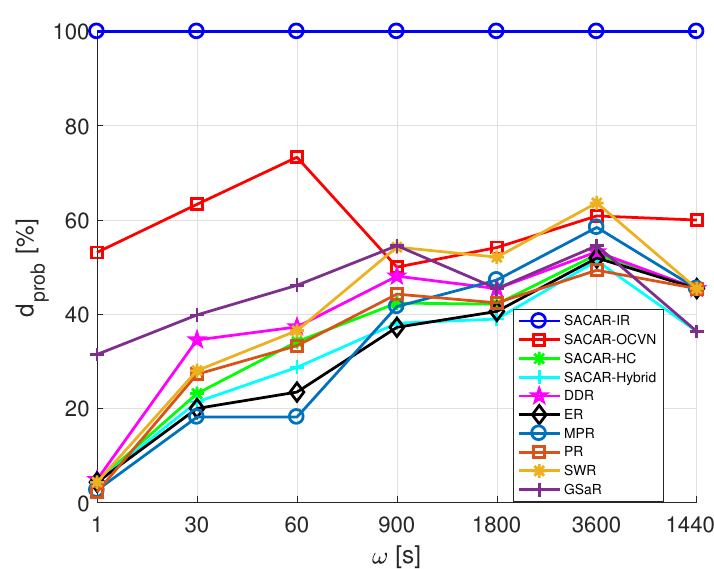
Figure 8. Average delivery probability ( d prob ) vs. the frequency of messages generation ( ω ): smart office scenario. DDR, Direct Delivery Routing; ER, Epidemic Routing; MPR, MaxProp Routing;